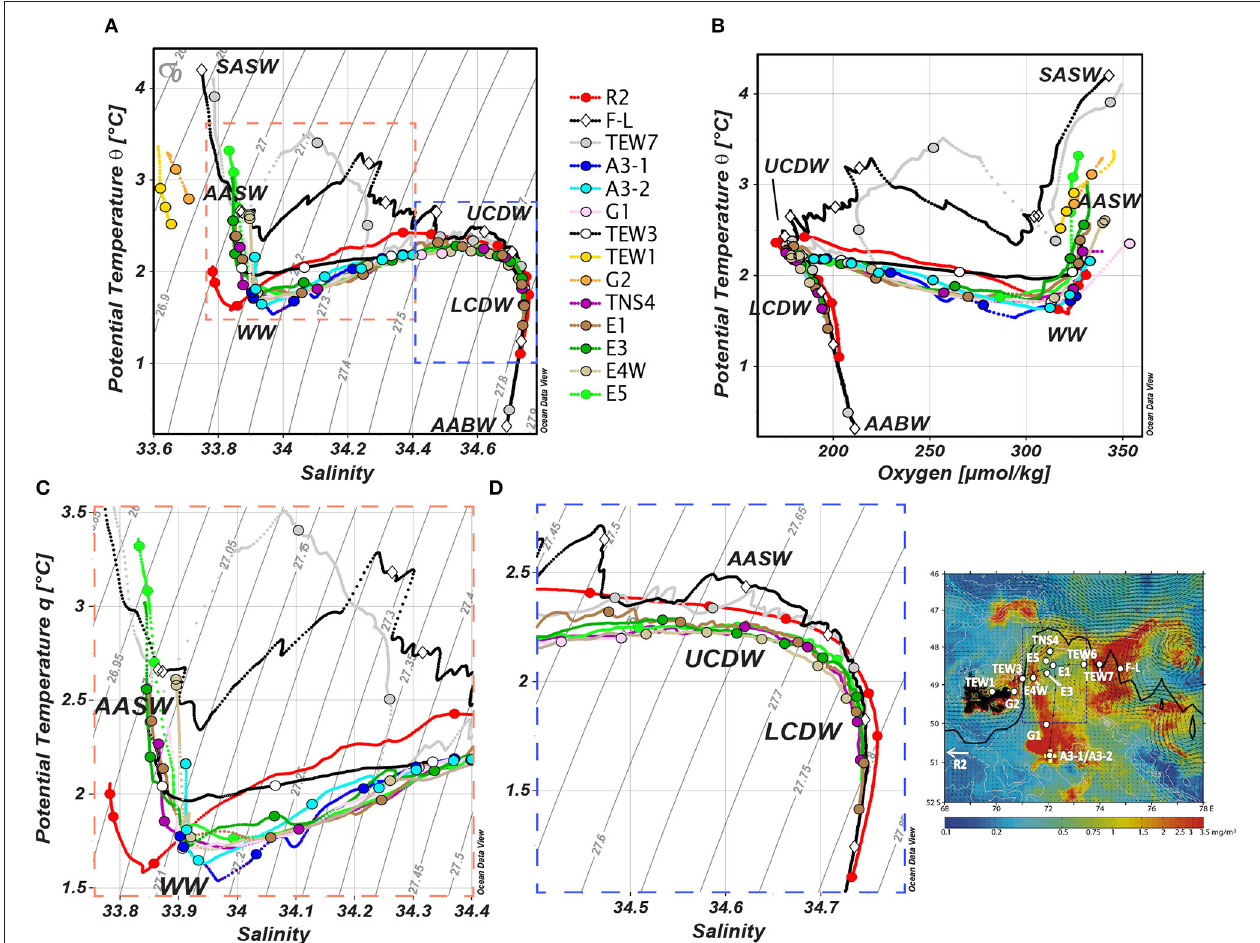
FIGURE 2 | (A) Potential temperature ( θ , in ◦ C)-salinity (S) plots and (B) potential temperature ( θ , in ◦ C)-oxygen (O 2 , in µ mol kg − 1 ) for the stations indicated in Figure 1B . Water masses are identified in black (SASW, Subantarctic Surface Water; AASW, Antarctic Surface Water; WW, Winter Water; UCDW & LCDW, Upper & Lower Circumpolar Deep Water; AABW, Antarctic Bottom Water). REE samples are identified by colored dots. Potential density contours are shown by the gray lines. The red and blue dashed squares in (A) define the θ -S zooms of the surface/subsurface waters and deep waters that are shown in (C,D) ,